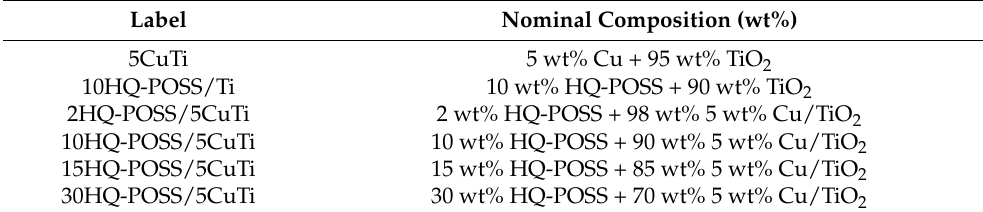
Table 1. Composition of samples.